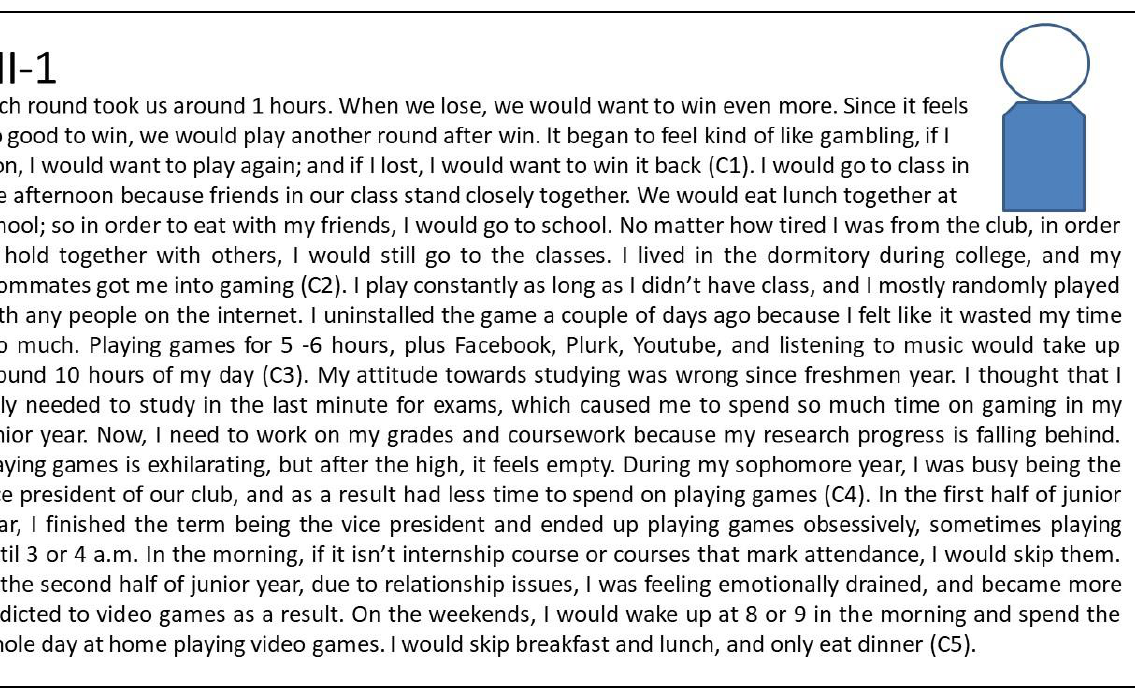
Figure 3. The person narrative about the third persona (II-1).